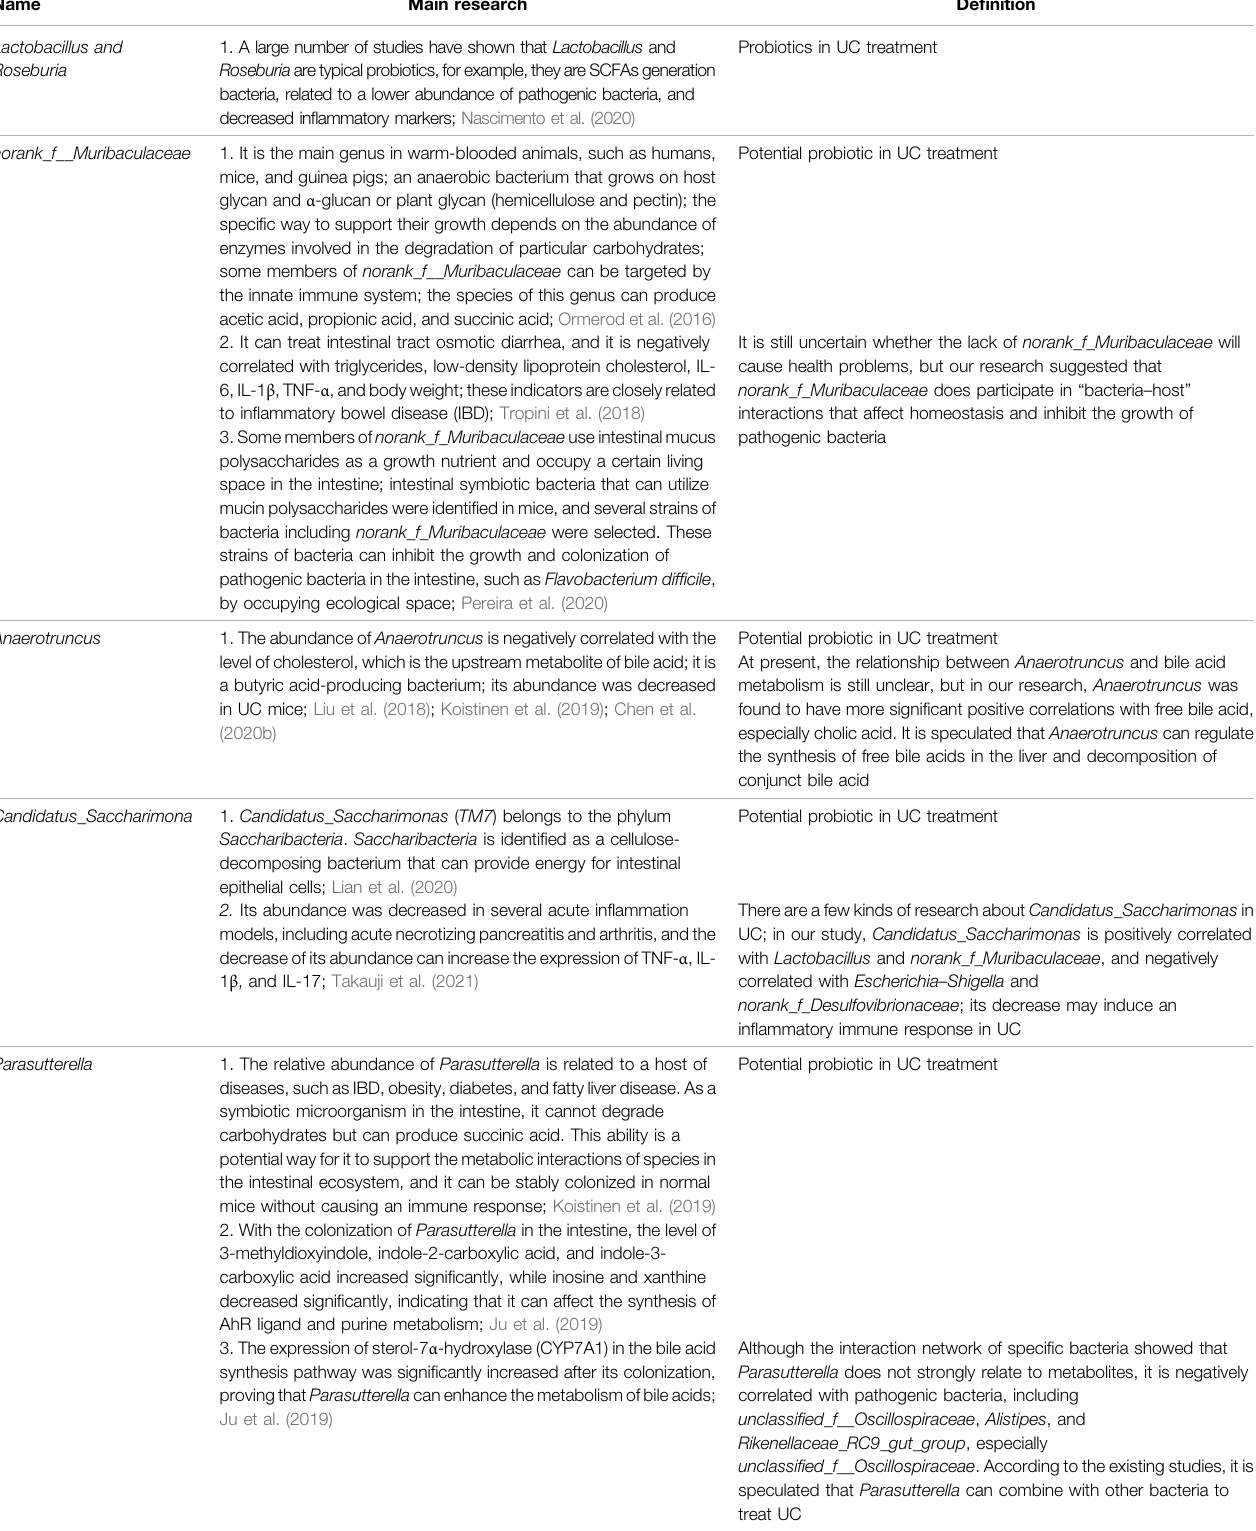
TABLE 1 | The main existing researches about the 6 functional speci fi c bacteria in our study.